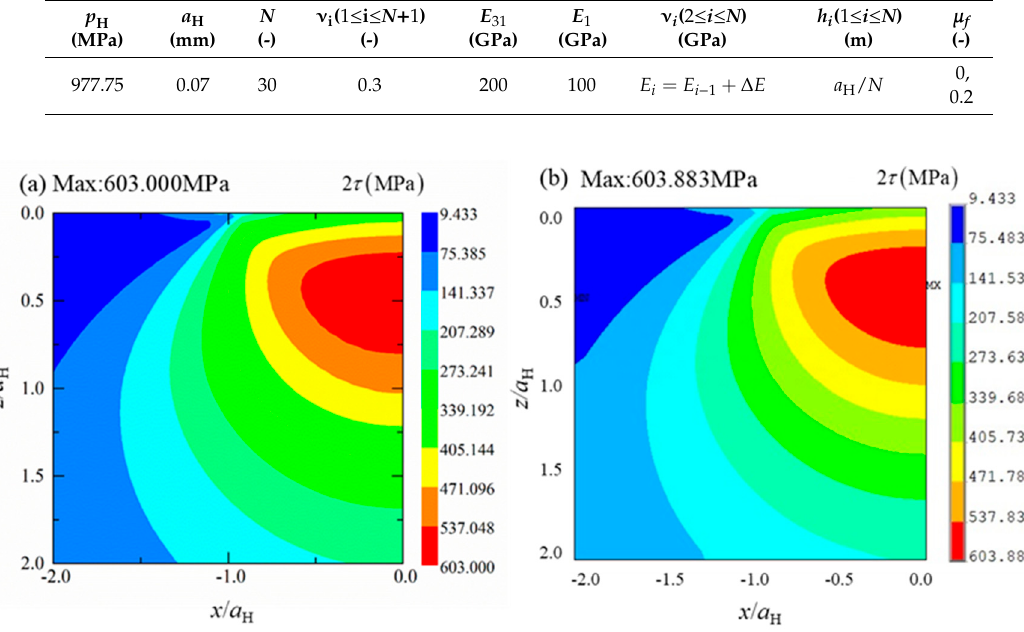
Figure 3. Comparison of the maximum shear stress in x - o - z plane between present solution and that of FEM solution, ( a ) maximum shear stress of present solution, ( b ) maximum shear stress of FEM solution.